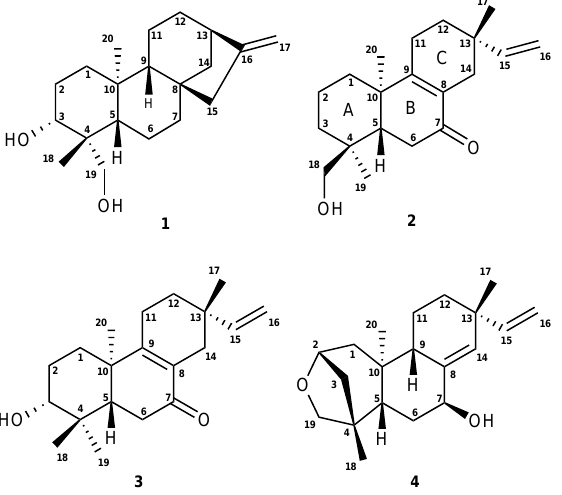
Figure 1. Chemical structures of diterpenes 1 – 4